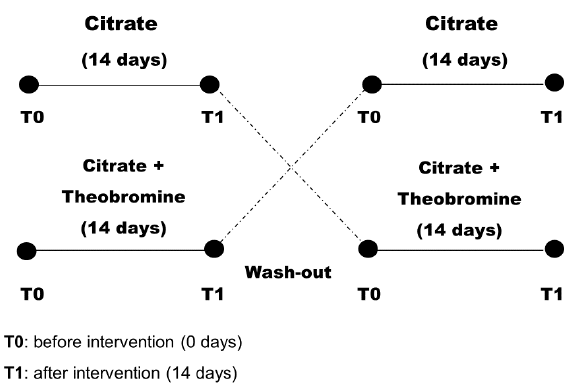
Figure 1. Design of the randomized crossover study of patients ( n = 47).